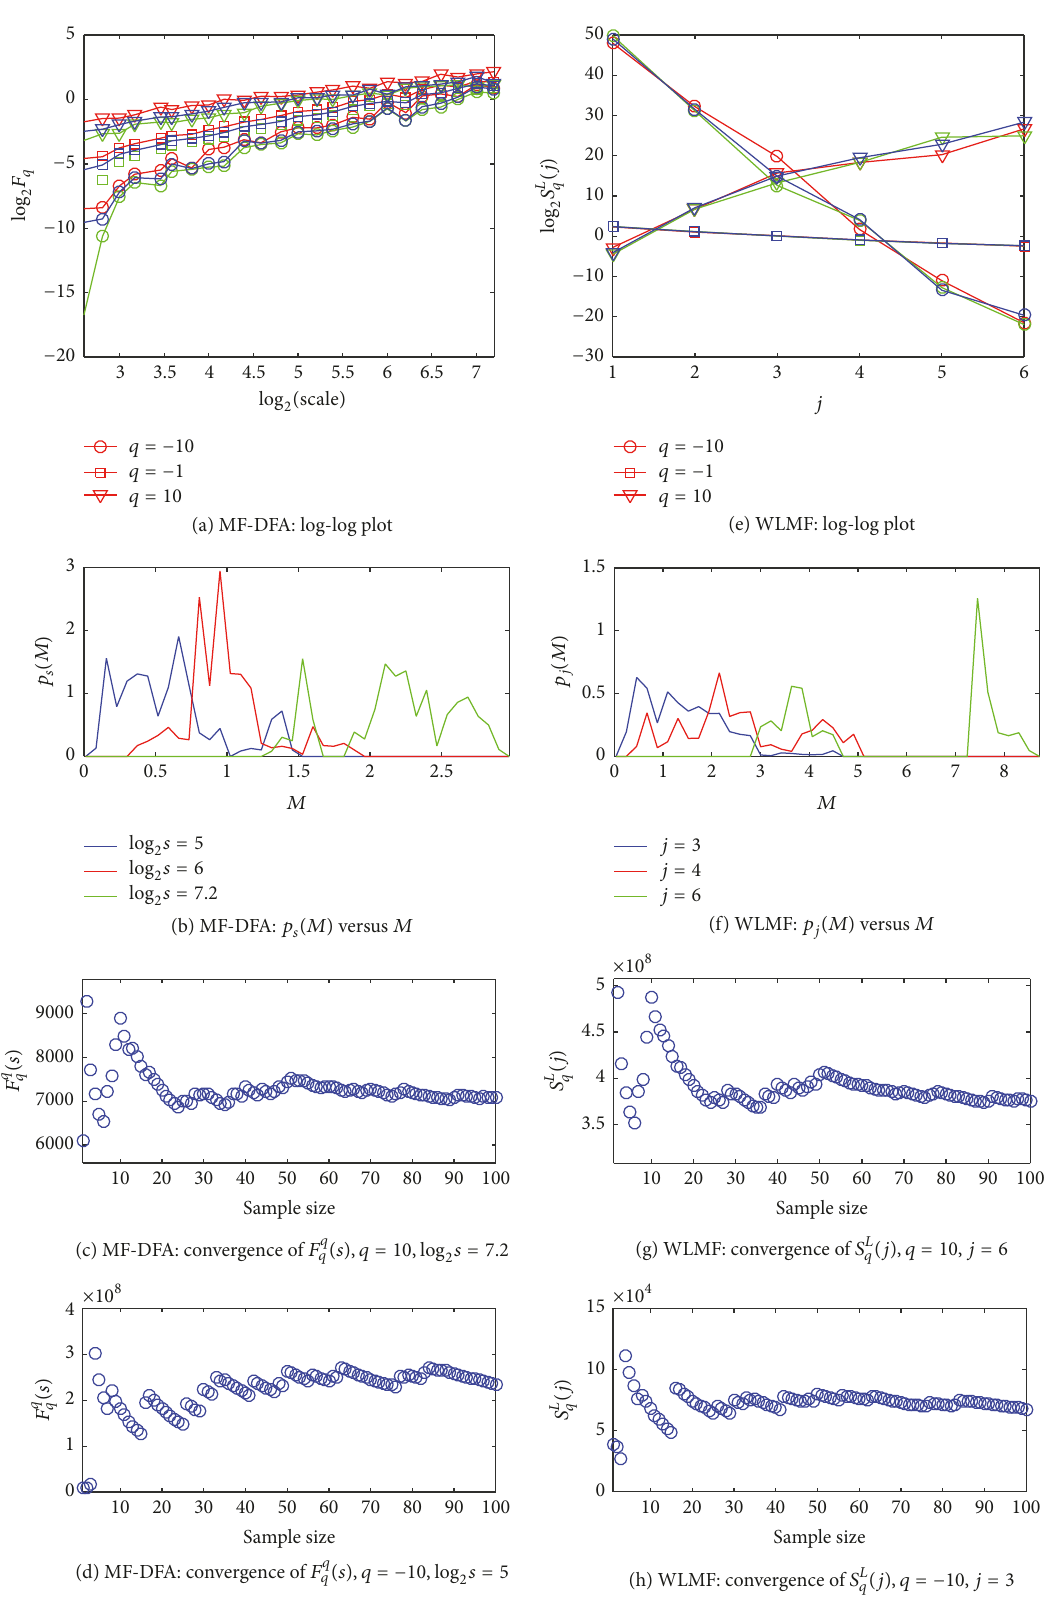
Figure 5: Statistical tests at Site 4. (a) and (e) show the log-log plots of MF-DFA and WLMF; different colors indicate different orders of polynomial (ordifferentvanishing momentsofwavelet). (a)2-order(red),3-order(blue), and4-order(green). (e)2-moment(red),3-moment (blue), and 4-moment (green). (b) shows the pdf of (𝐹 2 ( V ,𝑠)) 1/2 . (c) and (d) show the convergence of 𝐹 𝑞 𝑞 (𝑠) . The results in (b), (c), and (d) are based on 3-order. (f) shows the pdf of 𝐿 𝑋 (𝑗,𝑘) . (g) and (h) show the convergence of 𝑆 𝐿 𝑞 (𝑗) . The results in (f), (g), and (h) are based on 3-moment. These results correspond to an averaging over 100 sets of daily